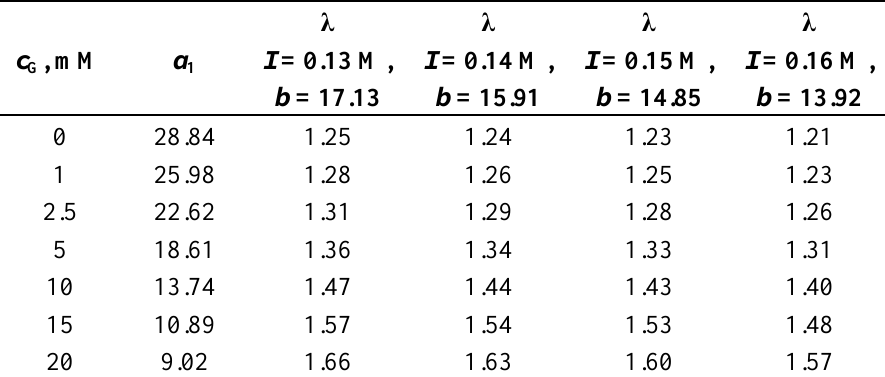
Table C4. Values of a , b , and λ for the different glucose concentrations c 1 solutions with pH7.4 and with the different values of the ionic strength I for the investigated AAm/3-AAmPBA/BIS layer ( g c = 2.23 M). 0